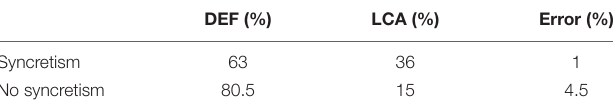
TABLE 1 | Results of the